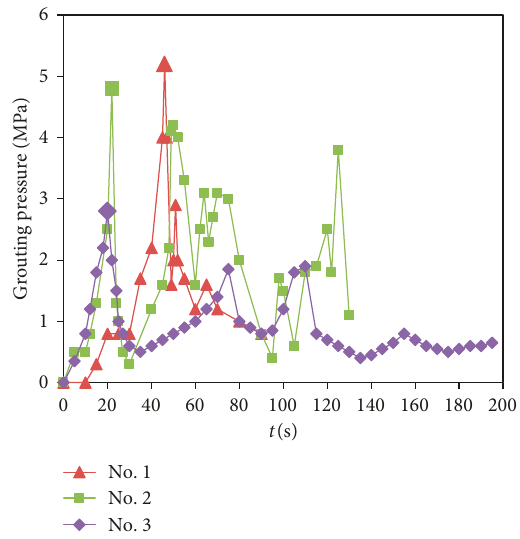
Figure 7: Double grouting pressure over time for Test